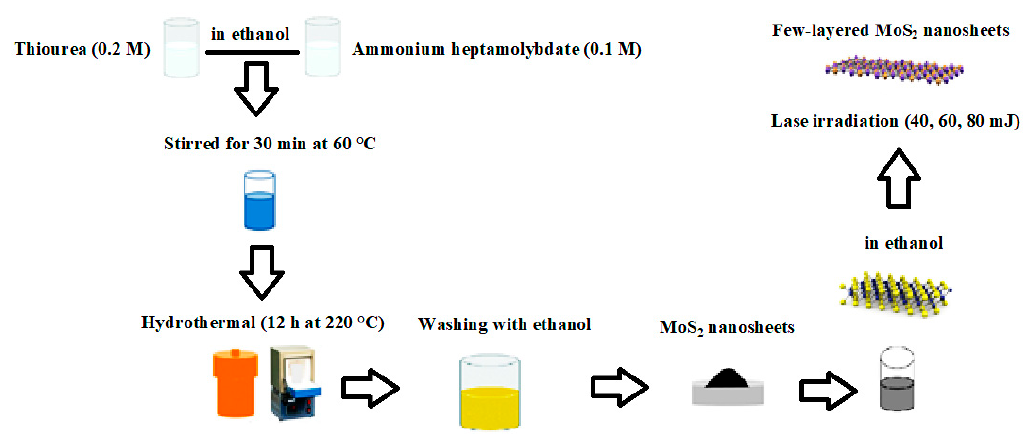
Figure 1. Flowchart of the synthesis process of the few-layered molybdenum disulfide (MoS 2 ) nanosheets.